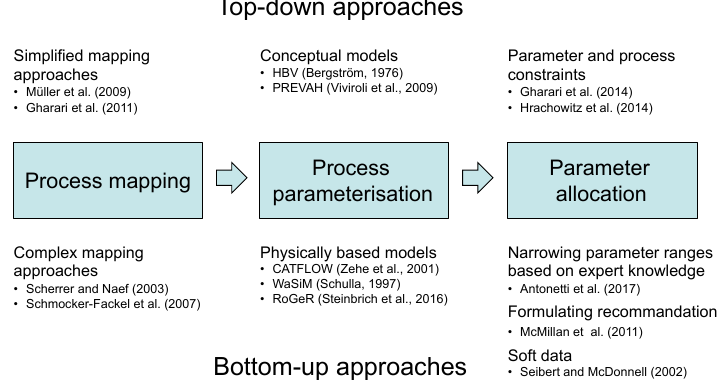
Figure 1. The three main steps for process-based flood predictions and the differences between the bottom-up (bottom) and top-down (top)